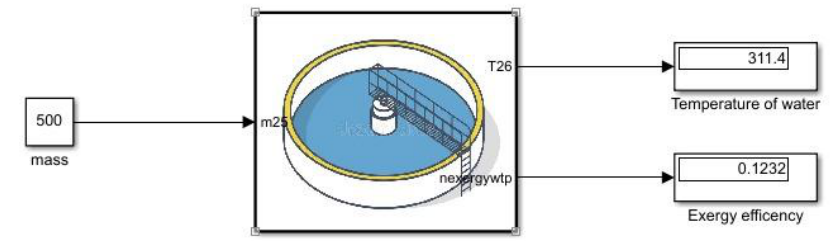
Figure 8. Water treatment Simulink